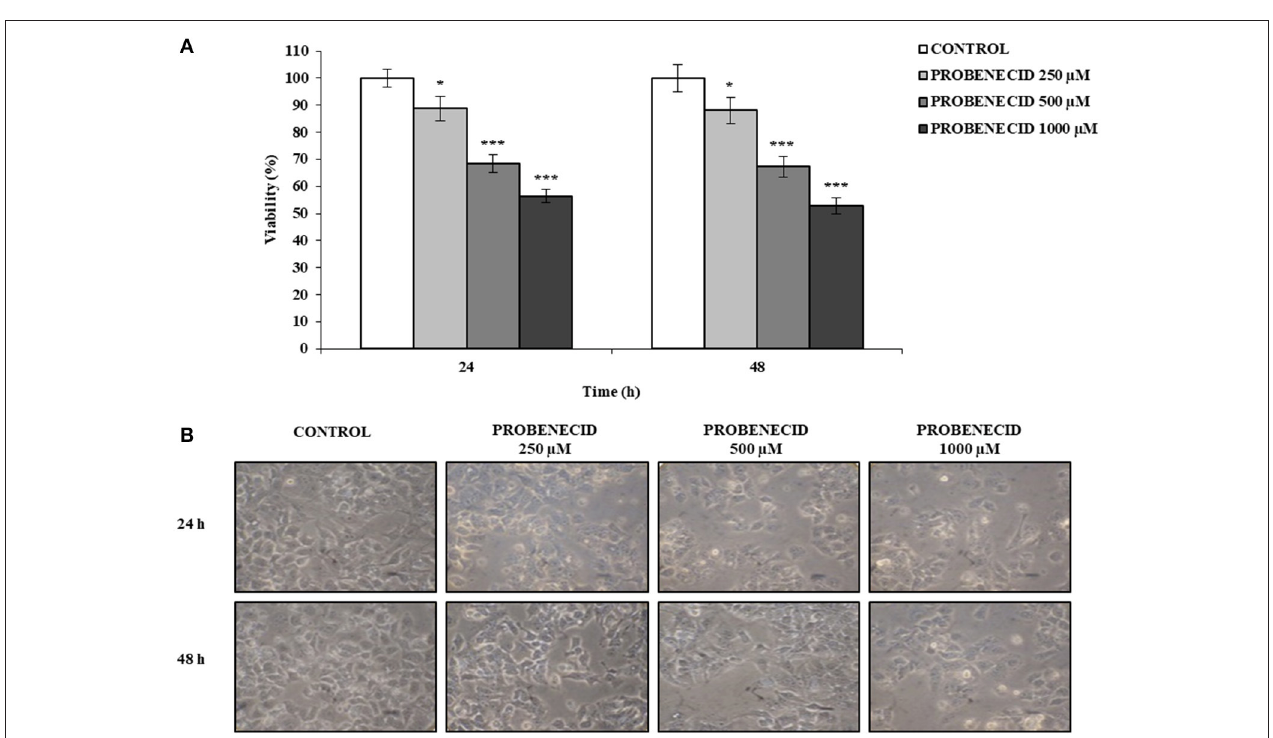
HepG2 cells, seeded at a density of 5 × 10 3 /well in 96-wells plates, were treated with different concentrations of Probenecid 5-diphenyl (250, 500, and 1,000 µ M) for 24 and 48 h. Cells were tetrazolium bromide) assay was used to assess cell viability.